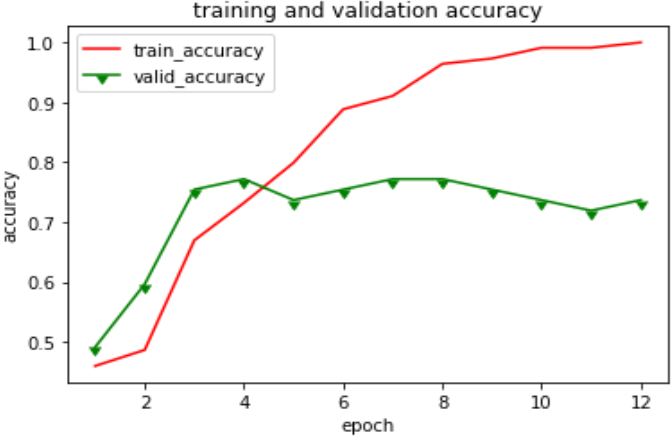
Figure 9. Training and test accuracy of naïve approach.